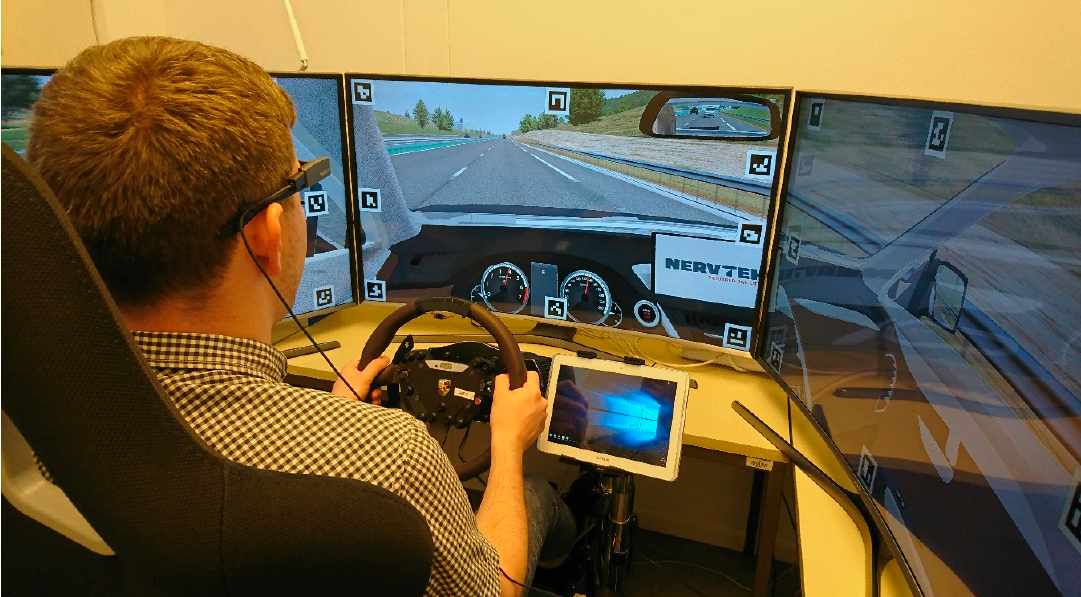
Figure 7. Obtaining user reporting behavior in professional driving simulator used for driver training.